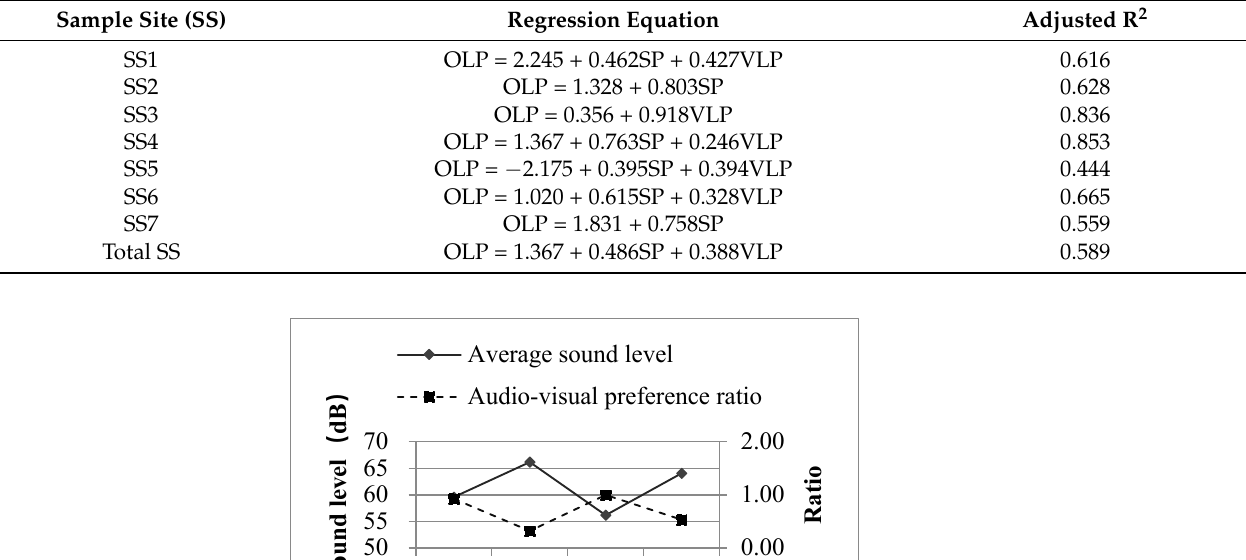
Table 4. Multiple linear stepwise regression analysis of OLP.